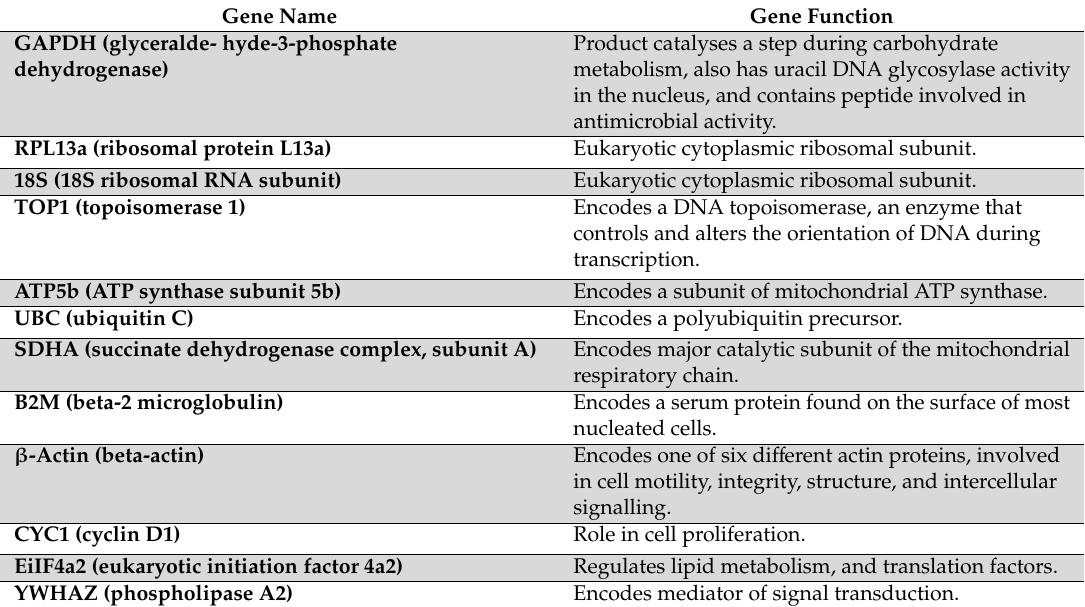
Table 2. The 12 housekeeping gene candidates and function. The genes function description is provided based on the information from the human genome database (GDB, http: //